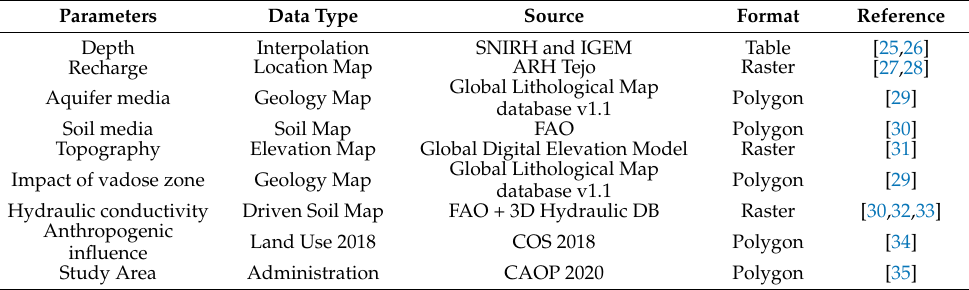
Table 2. Data type, source, format, and respective references of the DRASTIC/DRASTICAI